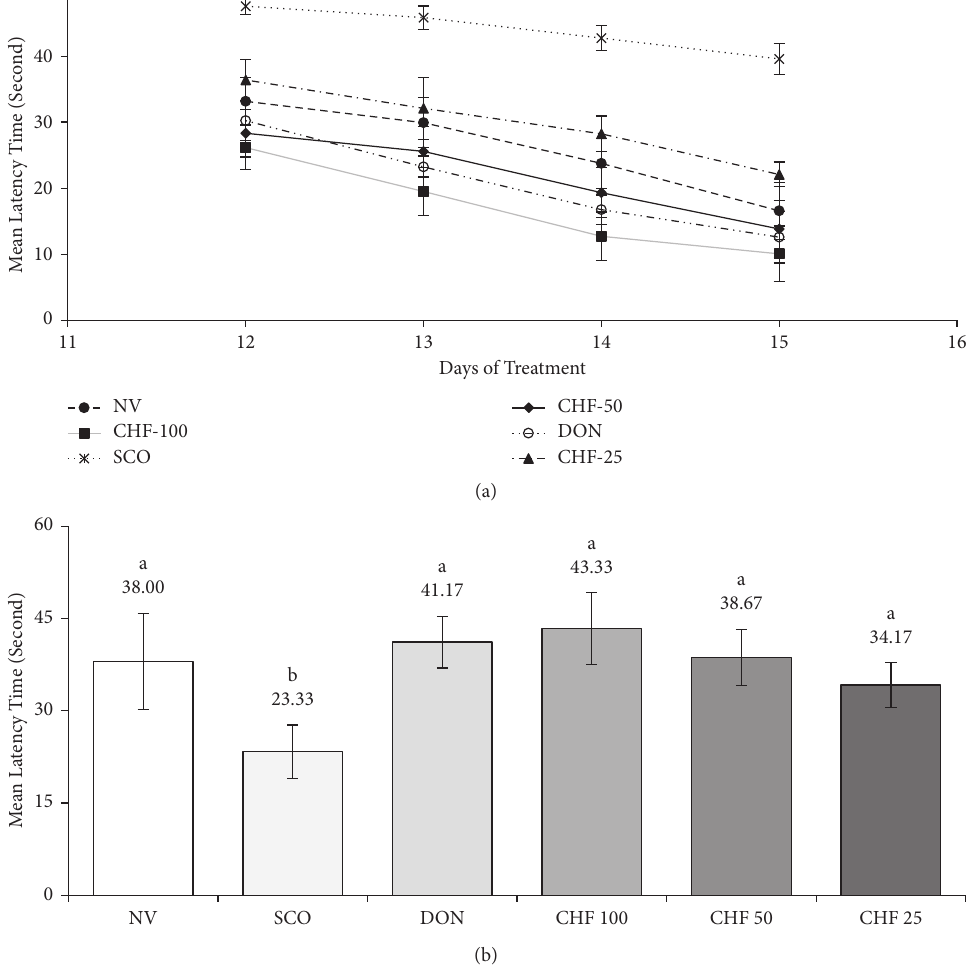
Figure 5: Effect of CHF on scopolamine-induced learning and memory impairments in mice by Morris water maze (MWM) task. (a) Changes in the mean latency time during 4 consecutive days of training for mice of different groups in the MWM task. (b) Average time spent in the platform quadrant by mice of different groups in the MWM probe trial. Each group was significantly different ( P < 0 . 05) from the disease control group (scopolamine-treated group). Values were expressed as MLT ± STD, n � 6 mice for each